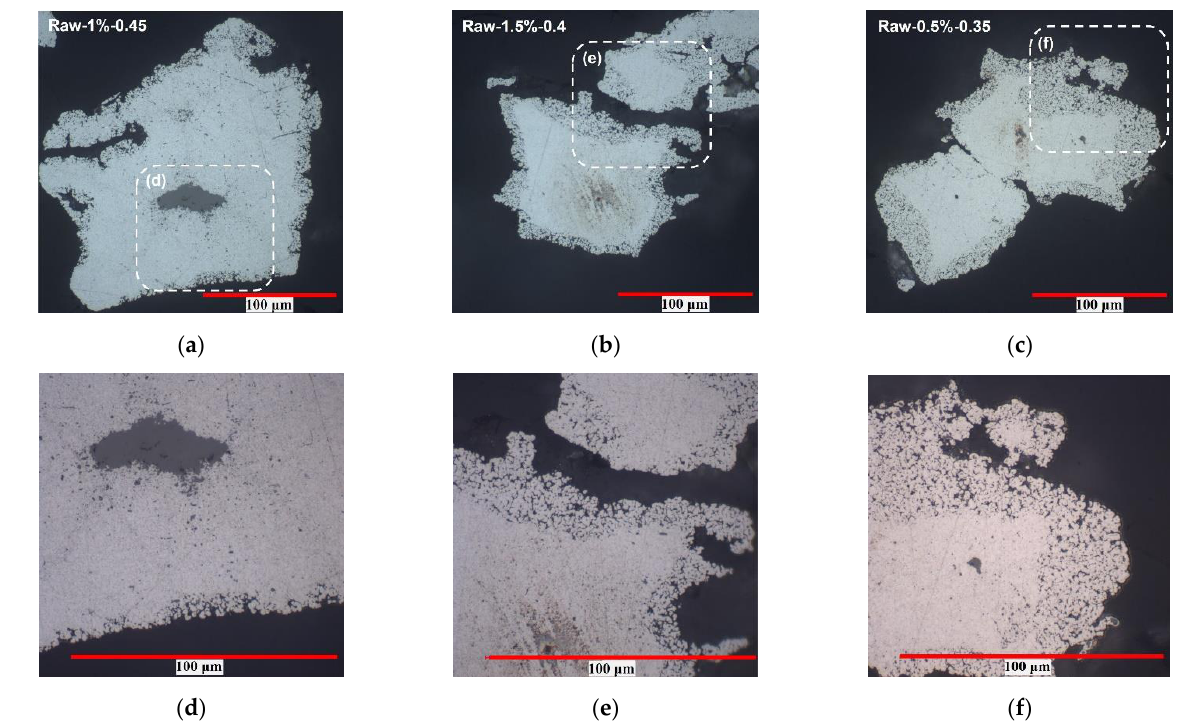
Figure 5. The polished section images of reduced iron ores: ( a , d ) Experiment No.8; ( b , e ) Experiment No.3; ( c , f ) Experiment No.7.